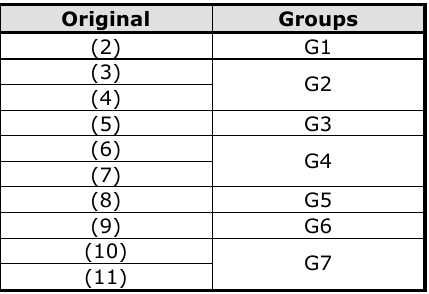
Table 1. “Grouping of the original sets of constraints”.